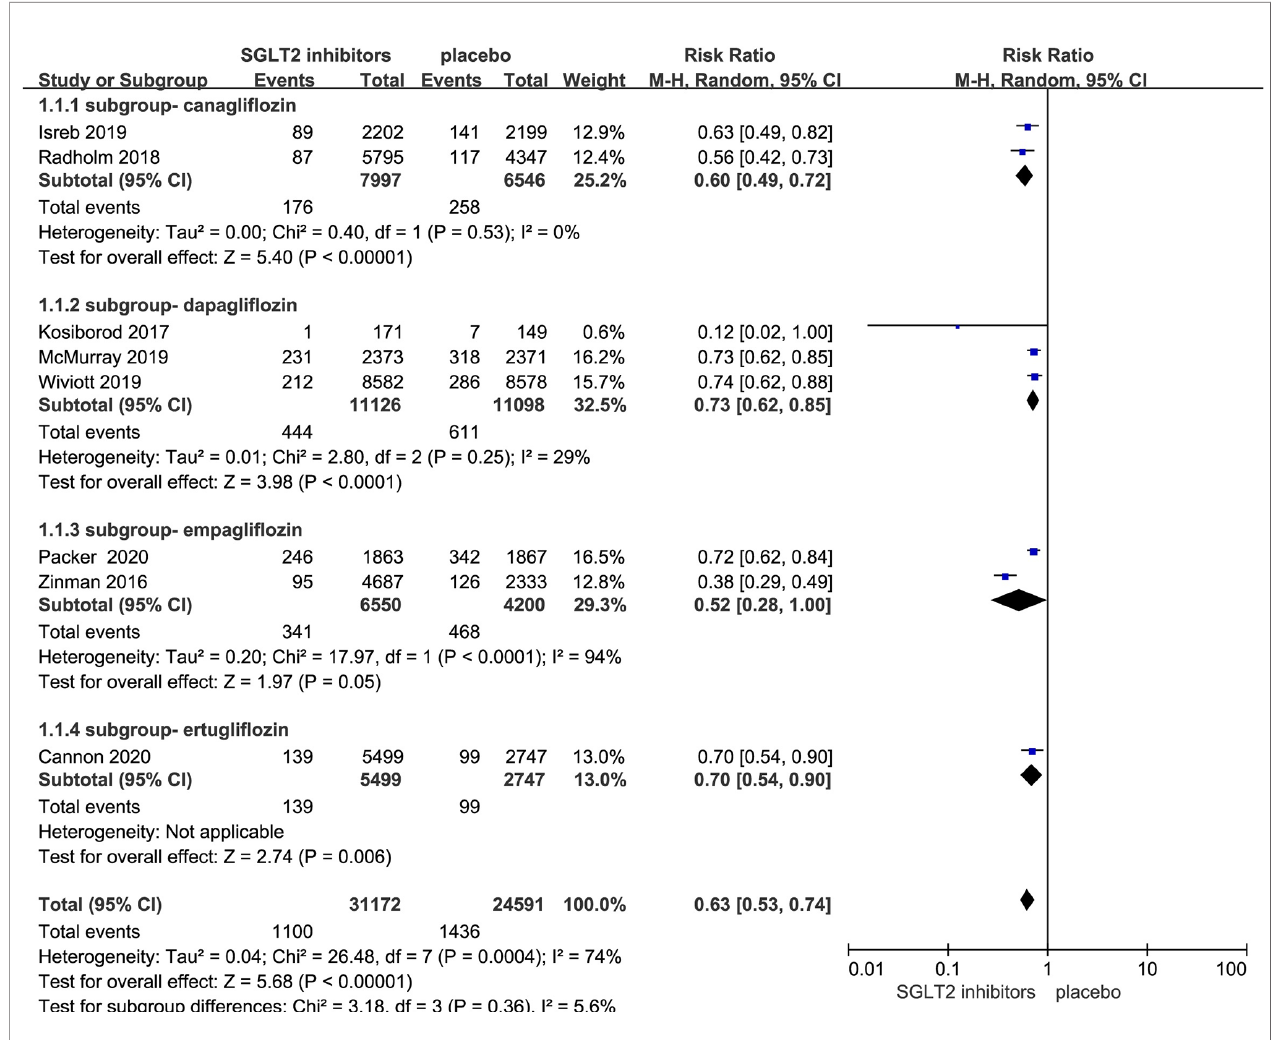
FIGURE 2 | Heart failure hospitalization in type 2 diabetes patients receiving SGLT2 inhibitors versus